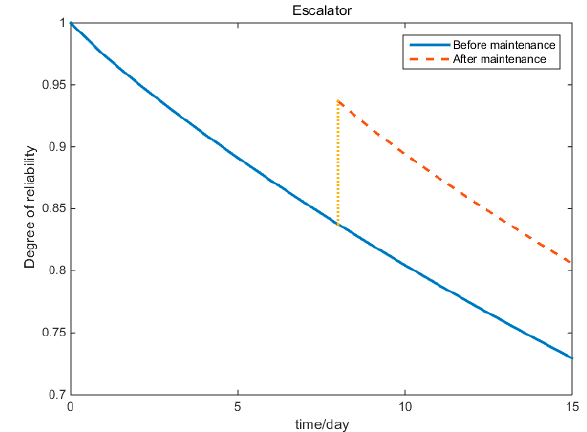
Figure 17. The reliability change due to the maintenance of escalators.